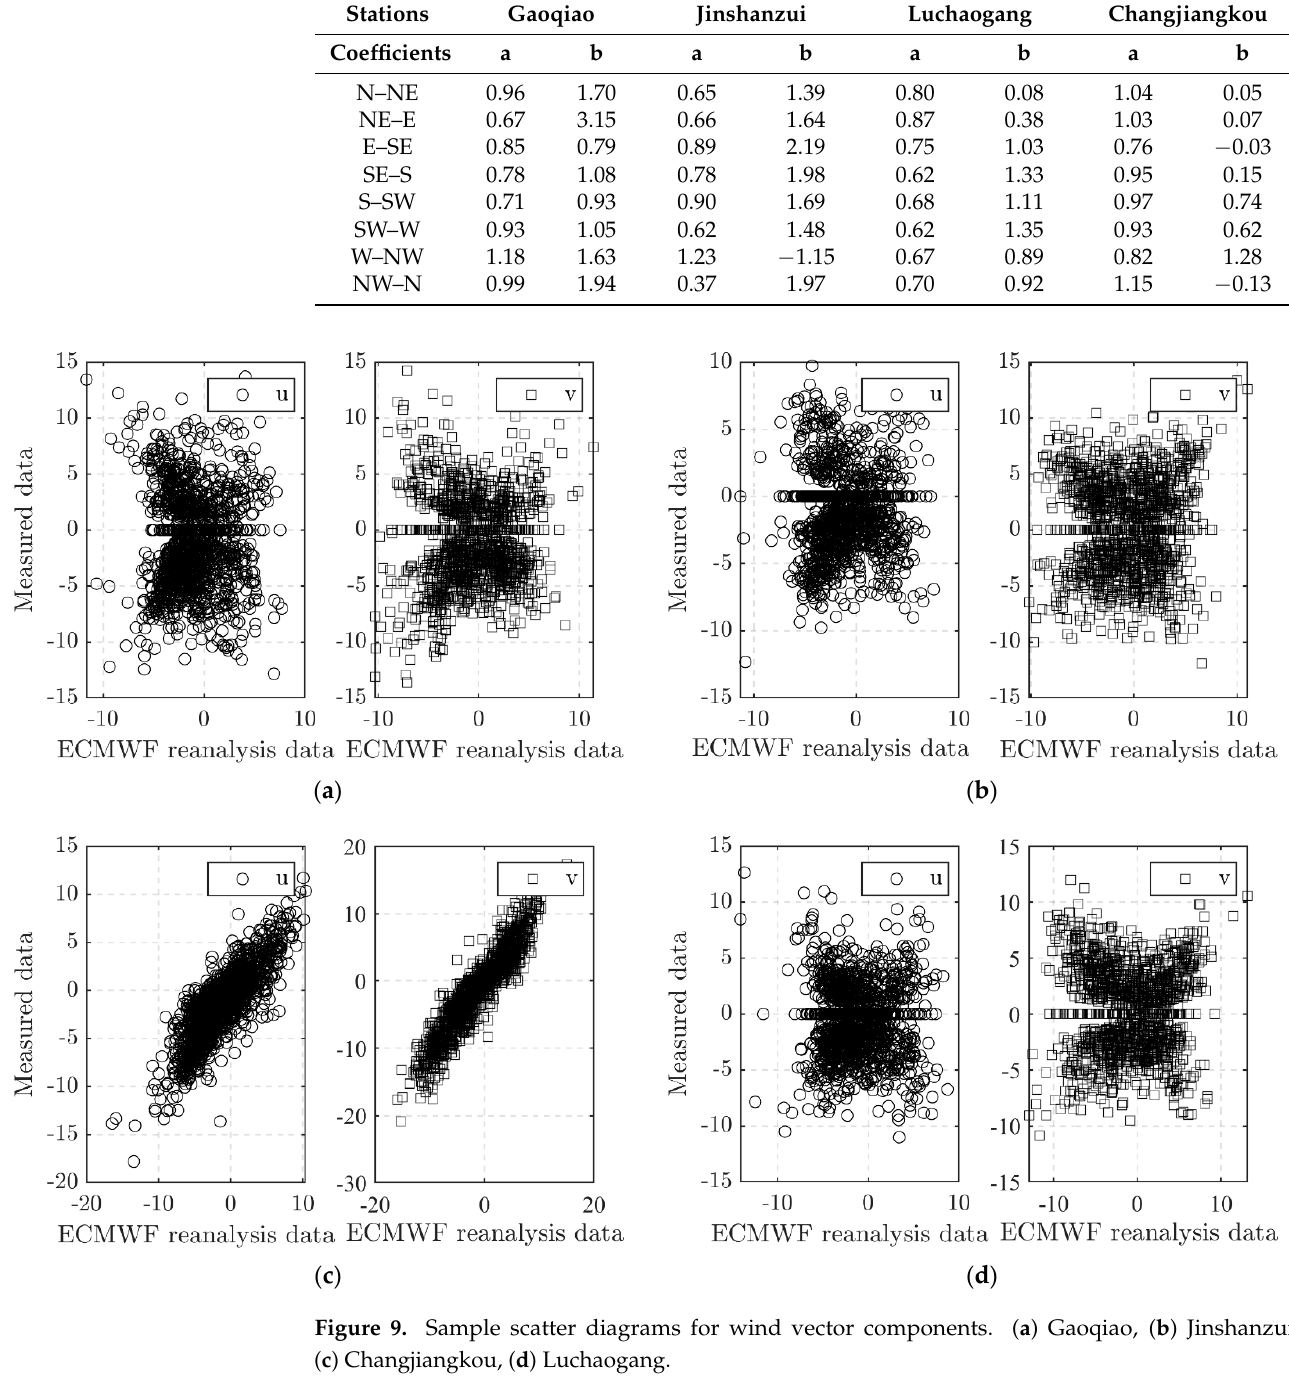
Table 2. Coefficients of corrections equations of wind speed at stations.